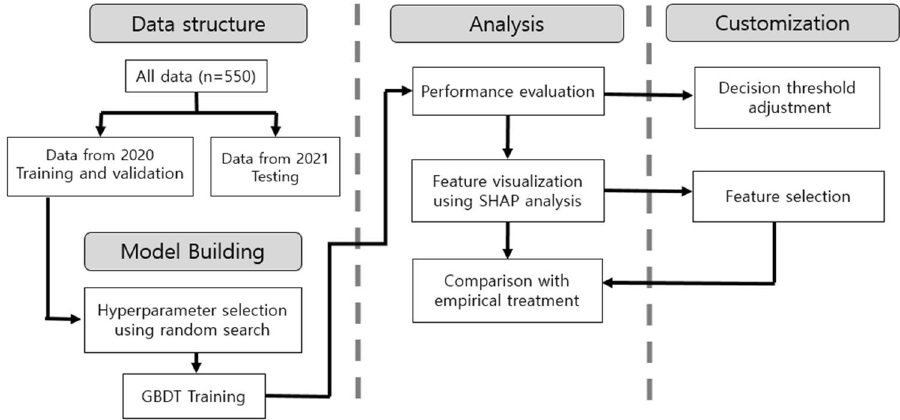
Figure 2. Abstract diagram of this study. GBDT: gradient-boosted decision tree, SHAP: Shapley additive explanations.